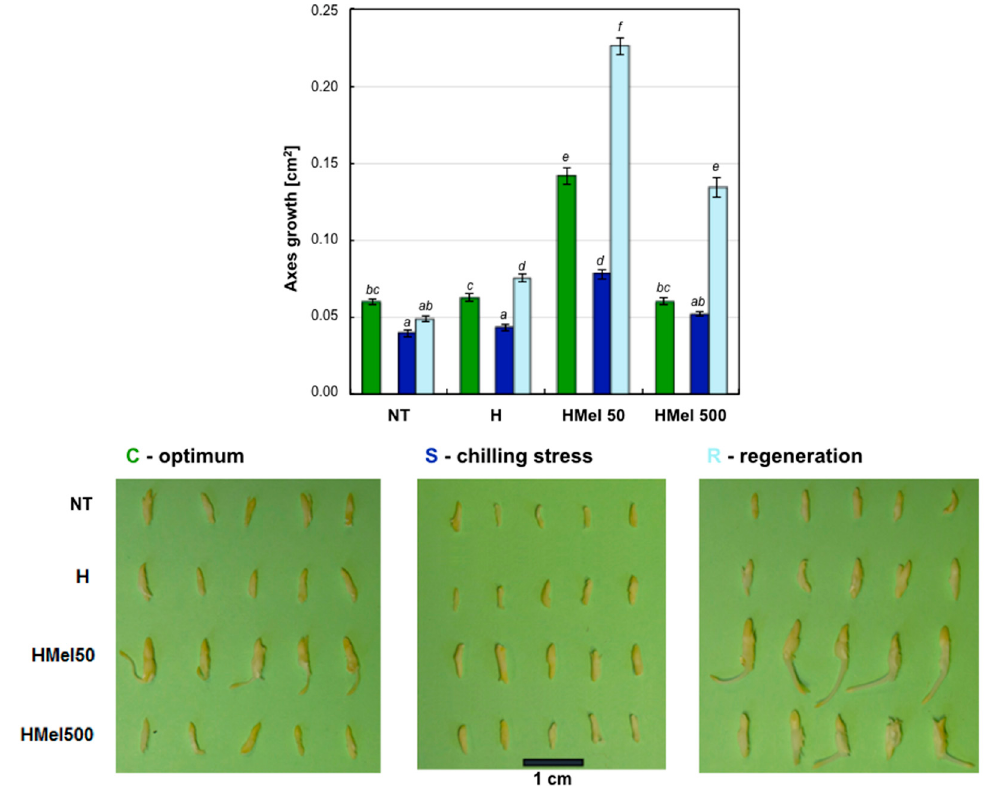
Figure 3. Effect of different maize seed hydropriming treatments on growth of the axes isolated from the non-treated seeds (NT), and those from hydroprimed with water (H) and with MEL water solutions in concentrations: 50 μ M (HMel 50) and 500 μ M (HMel 500). The seeds were im- bibed/germinated in water at 5 °C in darkness for 14 days (S [ ■ ]—chilling stress), and subsequently regenerated at 25 °C for 1 day (R [ ■ ]—regeneration). Growth was also estimated in axes isolated from the seeds germinated for 24 h under optimal conditions 25 °C (C [ ■ ]—optimum, control conditions). The results presented on graph are expressed as means of 20 – 40 measurements ±SEM. Two-way ANOVA and Duncan’s post-hoc tests were performed. The lowercase letters next to the values show statistical significance at the specified p . The results are also presented as a photo panel. GROWTH—ANOVA results: Seed Variant (NT,H,HMel 50,HMel 500) F (3;348) = 368.9, p < 0.000001; Conditions (C,S,R) F (2;348) = 267.4, p < 0.000001; interaction Seed Variant × Conditions F (6;348) = 67.2, p < 0.000001.